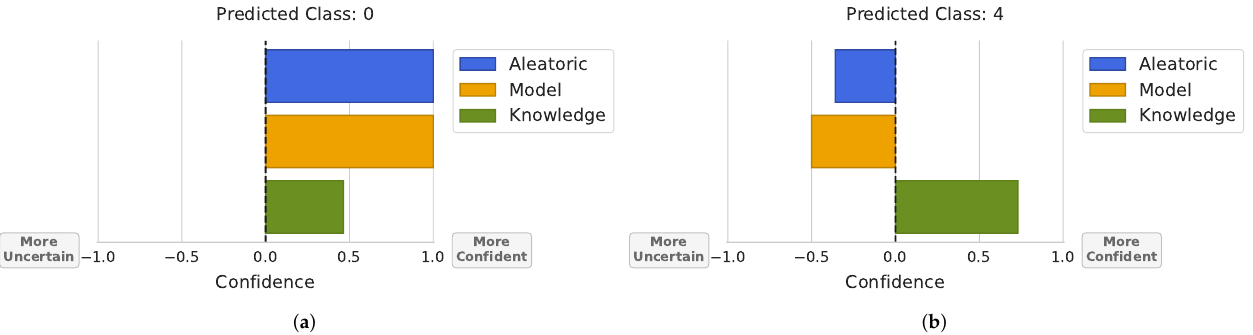
Figure 8. Prediction uncertainty. A confidence value of 0 represents the obtained threshold for reject- ing a sample by the uncertainty source. Bars’ sizes are normalized between the maximum theoretical confidence/uncertainty. ( a ) Prediction not rejected by all uncertainty sources. ( b ) Prediction rejected by aleatoric and model